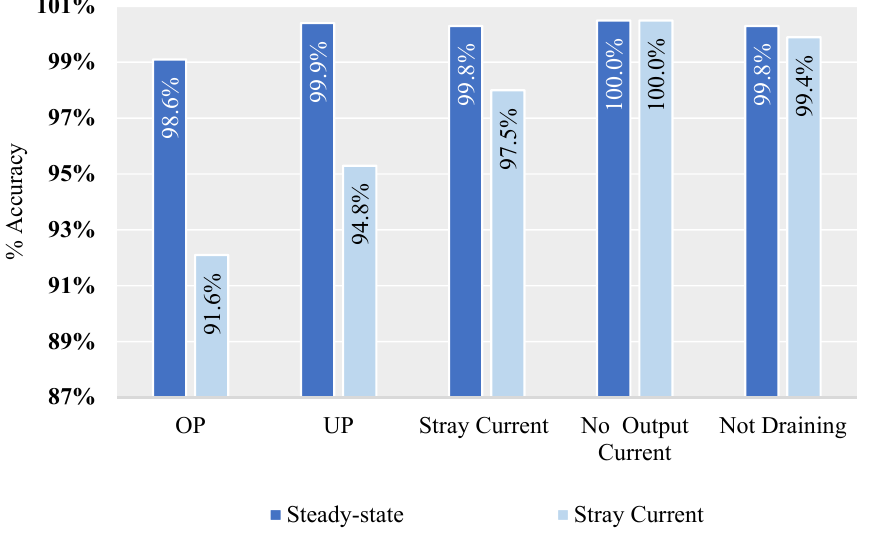
Figure 17. Maintenance suggestion prediction results.